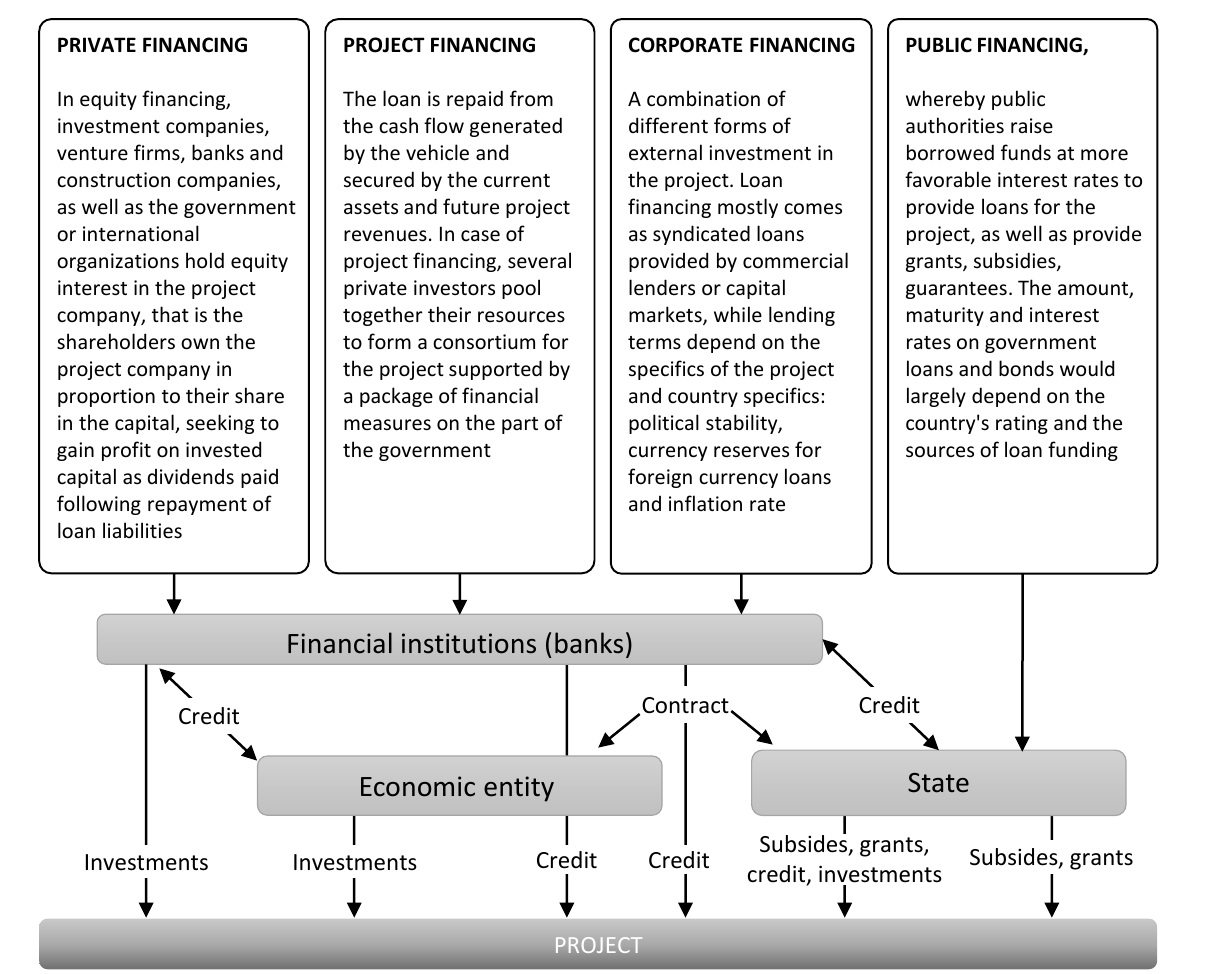
Figure 1. Forms of public-private partnership financing, compiled by